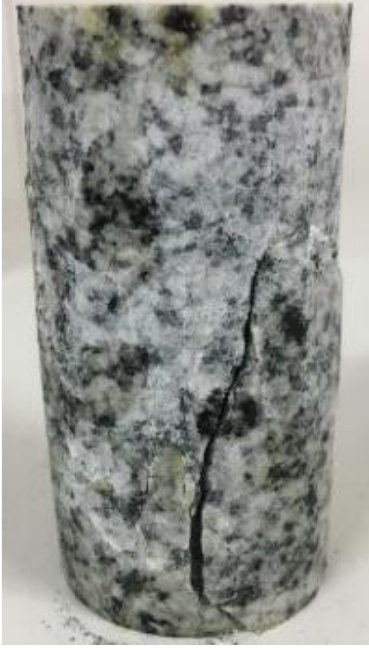
Figure 3. Uniaxial test results of weathered granite.